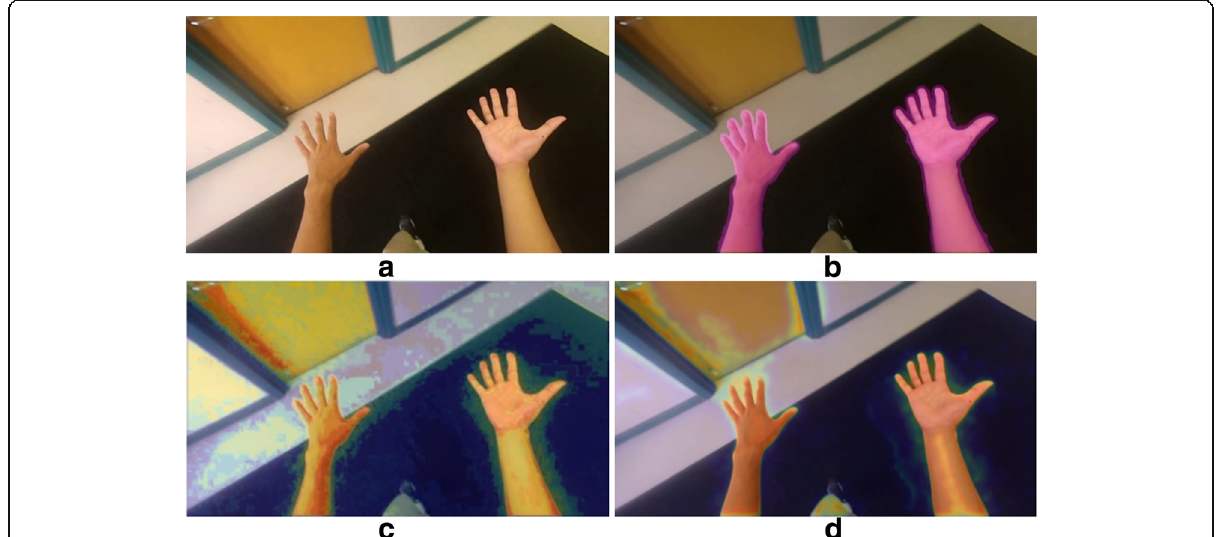
Fig. 7 a The original image has similar color in background and hand regions. From ( b – d ) are corresponding results of ours, Li and Kitani [1] and